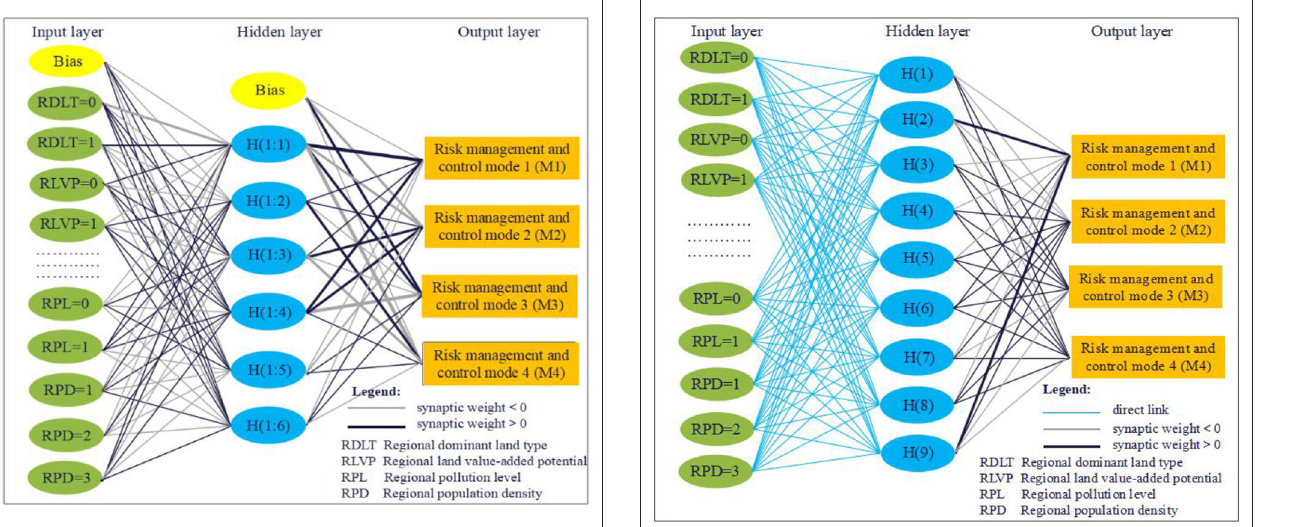
FIGURE 4 | The ANN model based on the RBF